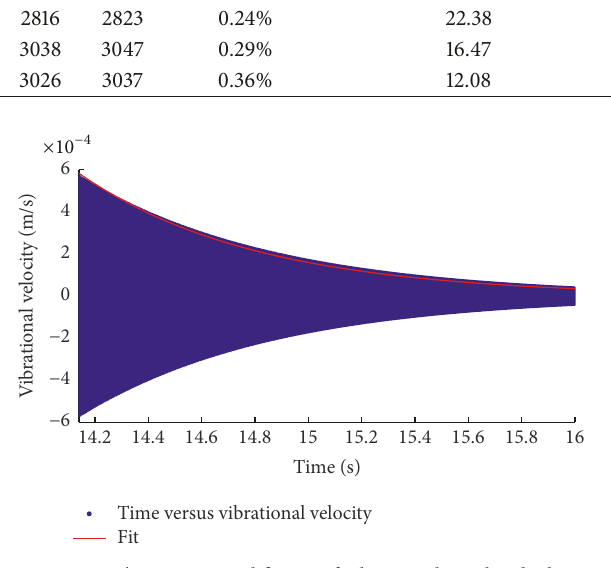
Figure 7: The exponential fitting of vibrational amplitude data.